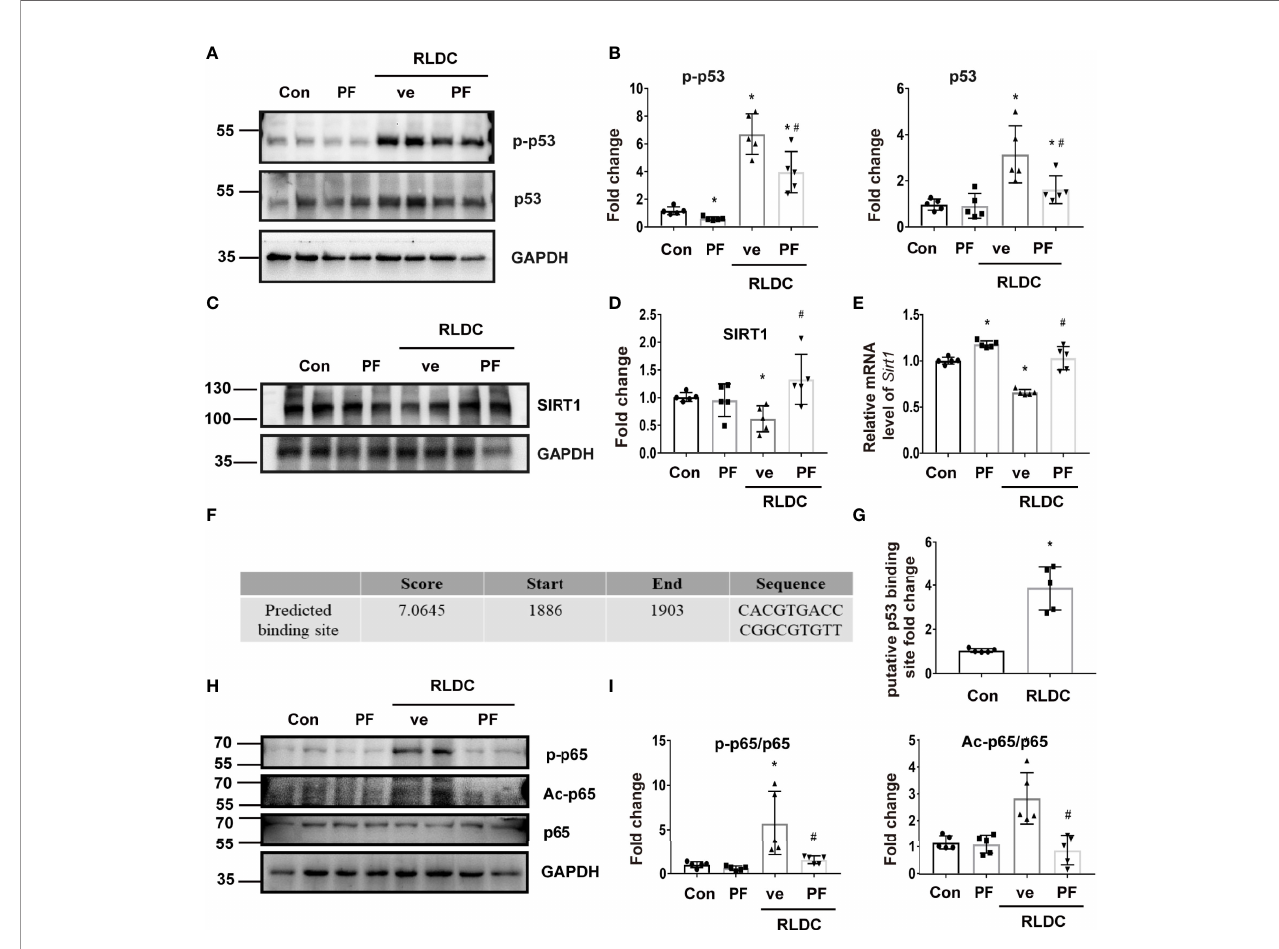
FIGURE 7 | p53 mediates the downregulation of SIRT1 in RLDC-treated renal tubular cells. BUMPT cells were incubated with 2 m M cisplatin for 7h each day for 4 days, and then treated with 25 m M pi fi thrin- a (PF) or vehicle solution (ve) for 17h in cisplatin-free medium. (A) Representative immunoblots of p-p53, p53 and GAPDH of cell total protein (n=5). (B) Densitometry of p-p53 and p53. The protein level of the control group was arbitrarily set as 1, and the signals of other conditions were normalized with the control group to indicate their protein fold changes. (C) Representative immunoblots of SIRT1 and GAPDH from total protein (n=5). (D) Densitometry of SIRT1. (E) Effect of PF on Sirt1 mRNA expression (n=5). (F) p53 binding site on Sirt1 gene promoter predicted by JASPAR database. (G) ChIP assay of p53 binding to SIRT1 promoter sequence after RLDC treatment (n=5). (H) Representative immunoblots of p-p65, Ac-p65, p65 and GAPDH from total protein (n=5). (I) Densitometry of p-p65 and Ac-p65. Data are expressed as mean ± SEM. * P <0.05 vs . the control group (Con), #P < 0.05 vs . RLDC with vehicle solution group (RLDC +